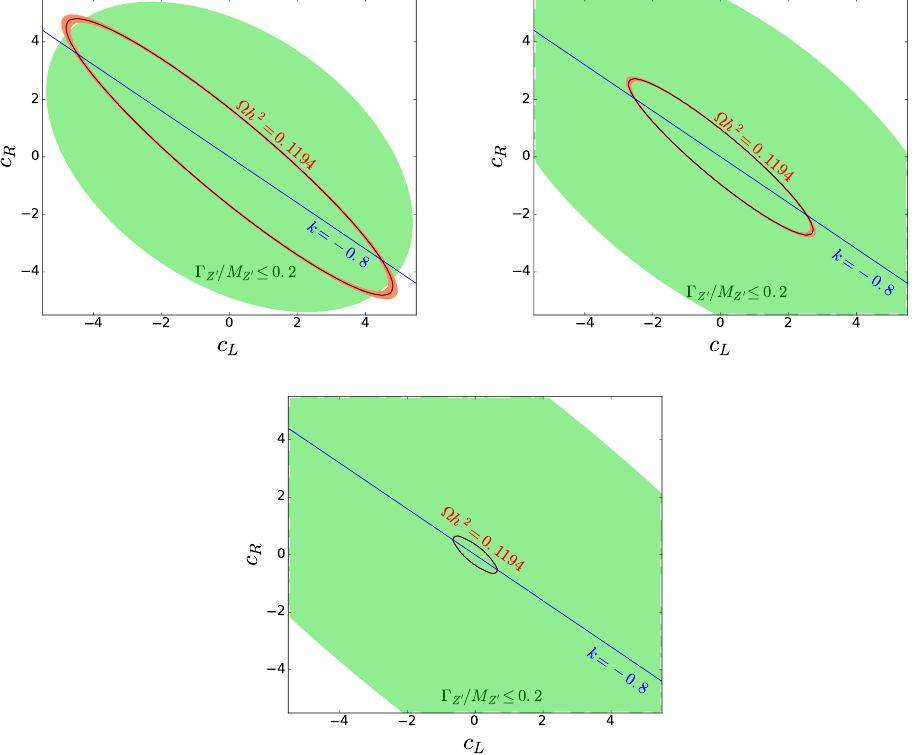
Figure 1 . Interplay between the region (cid:0) Z 0 =M Z 0 0 : 2 (green region) and observed dark matter (cid:20) abundance [57] (cid:10) h 2 = 0 : 1194 (black line with orange contours), for M Z 0 = 1 : 5 TeV, (cid:1) m = 5 GeV, k = 0 : 8 (blue line) and c ( f ) = 0 : 07, for di(cid:11)erent values of m 1 : m 1 = 525 GeV (left-top panel), L (cid:0) m 1 = 610 GeV (right-top panel), m 1 = 700 GeV (bottom panel). The orange contours correspond to 3 (cid:27) deviations from the best